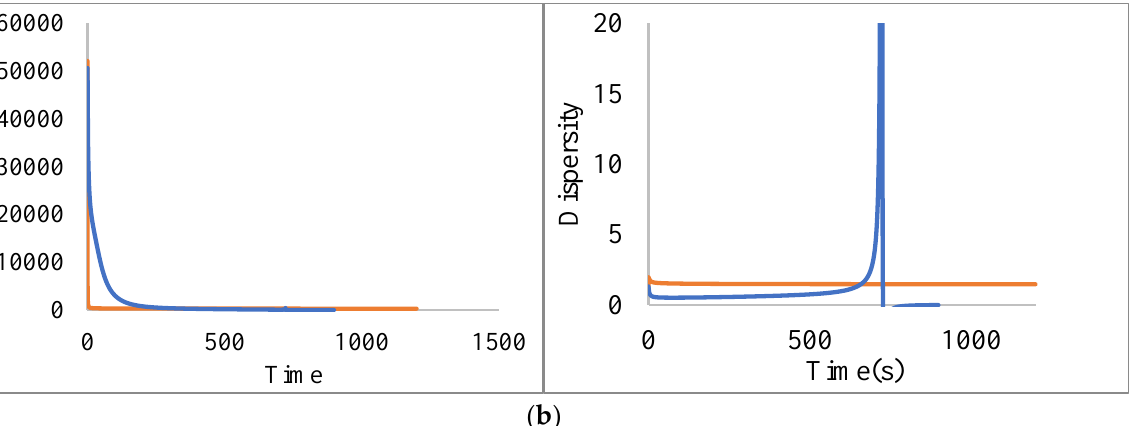
Figure 8. Comparison of M n and dispersity evolution in reaction time of the pyrolysis simulation of polystyrene: ( a ) synthesized via FRP, and ( b ) synthesized via NMP with N/I= 1.1. The temperature for the calculations was assumed to be 350 °C.